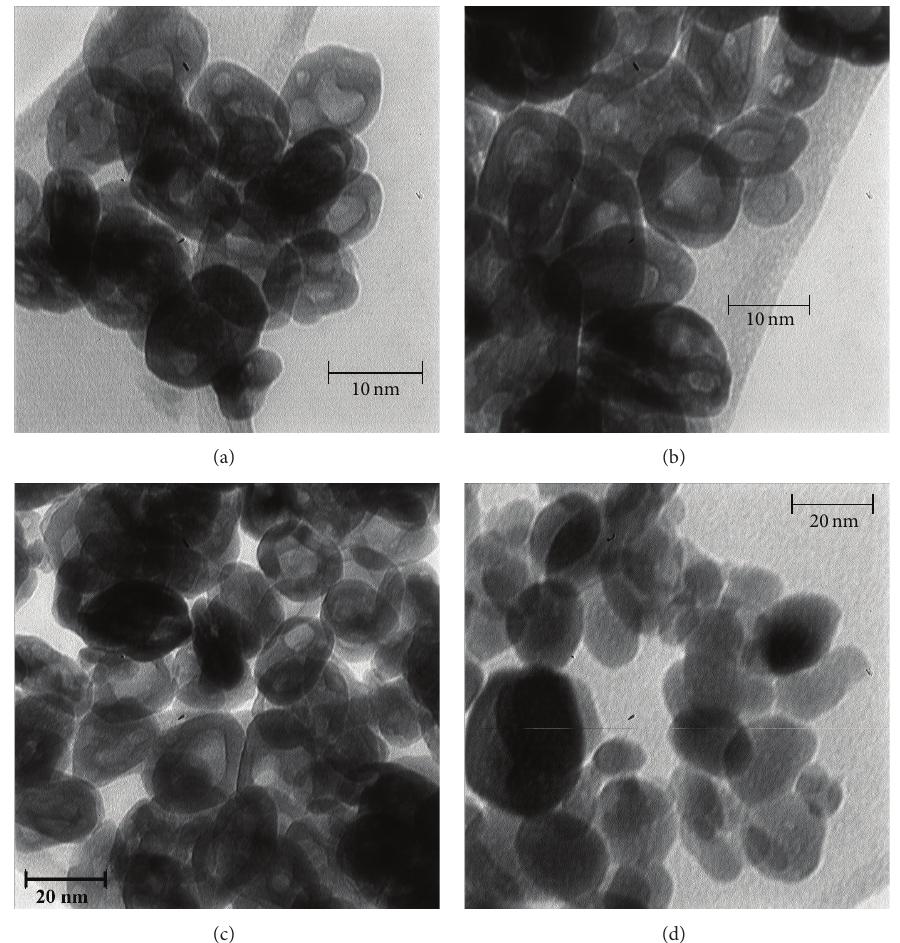
Figure 4: TEM image of prepared catalysts after calcinations ((a) HLB = 13.9, (b) HLB = 23.7, (c) HLB = 31.2, and (d) HLB =